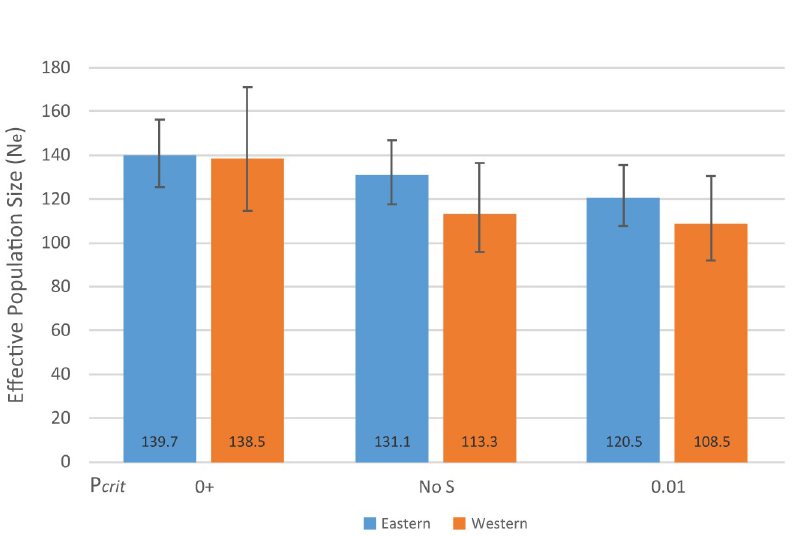
Fig 5. Effective population size (N e ) calculations with upper 95% confidence intervals. Estimates of N e with P crit set to frequencies of 0.00 (0+), 0.01, and to exclude only singleton alleles (No S).